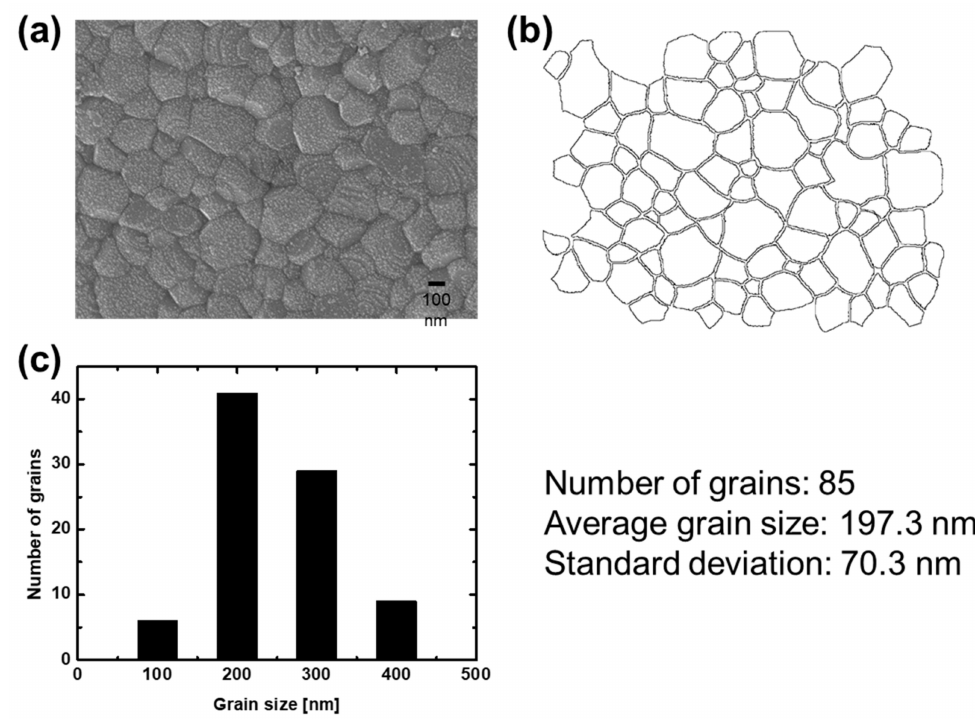
Figure 6. ( a ) SEM image of sample heat-treated at 1200 ◦ C for 25 h, ( b ) image analysis and ( c ) histogram of grain